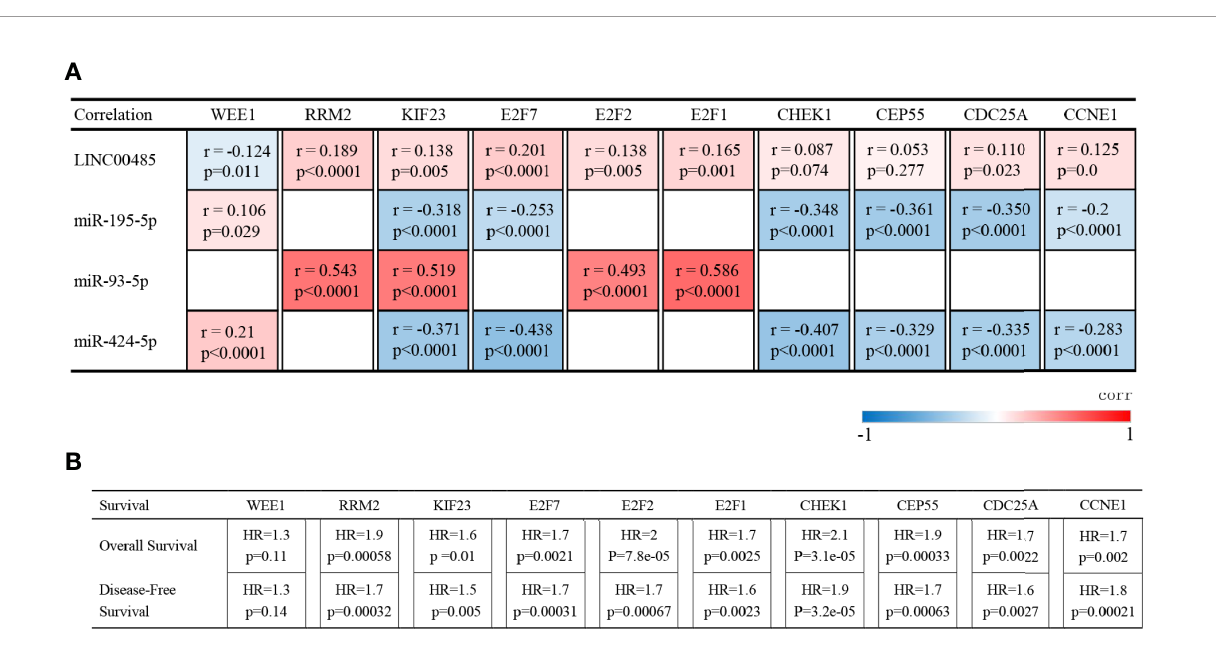
FIGURE 8 | Veri fi cation of lncRNA – mRNA and miRNA – mRNA pairs. (A) Correlation between expression levels of LINC00485 , miR-195-5p, miR-93-5p, miR-424-5p, WEE1, RRM2, KIF23, E2F7, E2F2, E2F1, CHEK1, CEP55, CDC25A and CCNE1 in the same HCC patients derived from TCGA database. Pearson correlation was applied to explore the relevance. The colored blocks at different positions re fl ect the level of correlation between the corresponding molecules. (B) Impact of hub genes expression on HCC patients ’ overall survival and disease-free survival analyzed by GEPIA. HR: HR